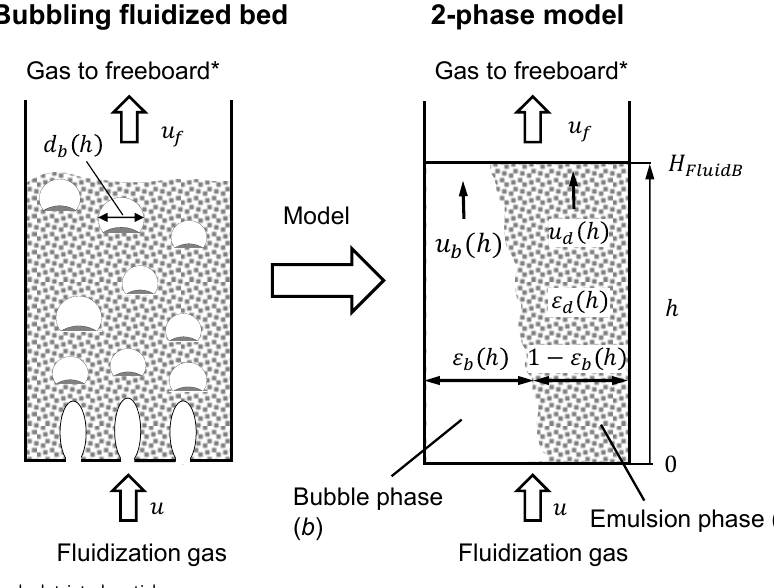
Figure 3. Simplified reactor scheme of the modeled process.